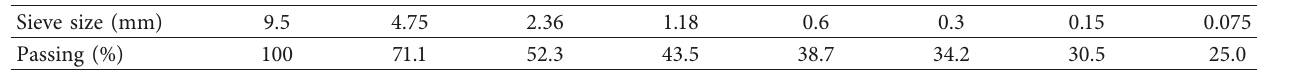
Table 2: The aggregate gradation for the GA mixture